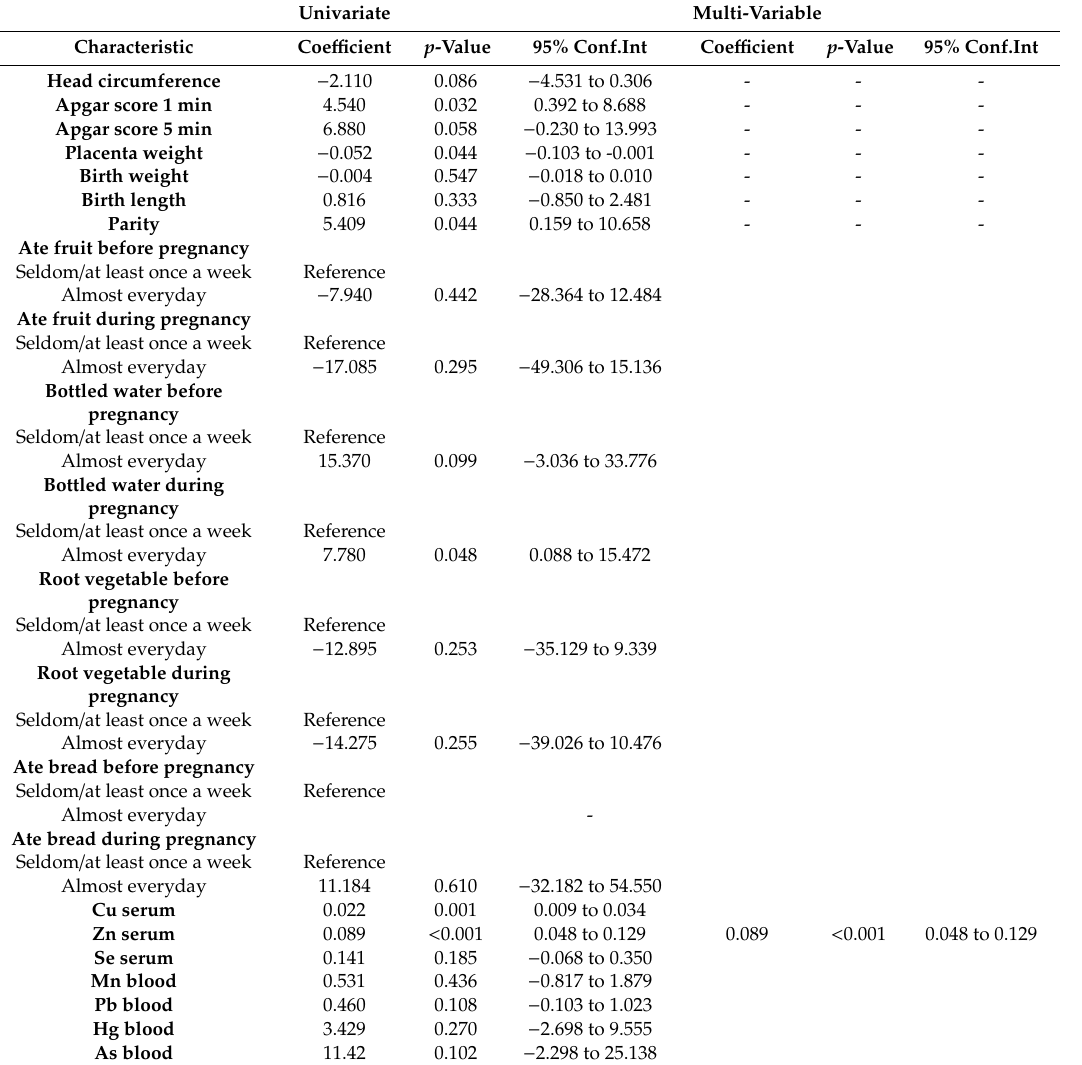
Table 7. Coe ffi cient estimates of quantile regression at 50% quantile-univariate and multi-variable regression for male neonates.